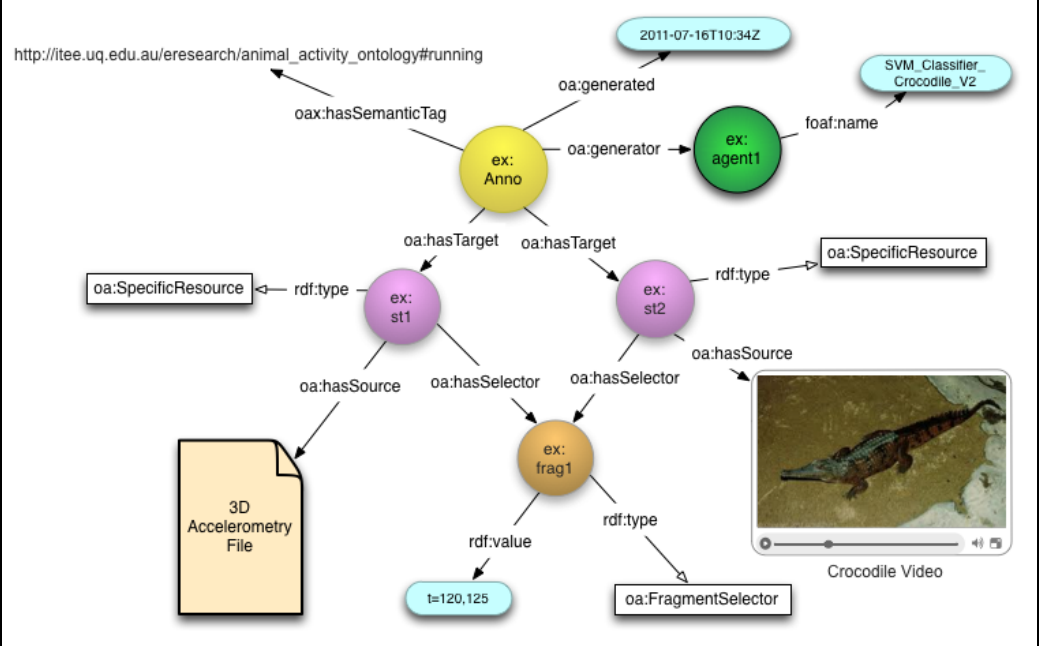
Figure 8. OA representation of an automatically generated animal activity